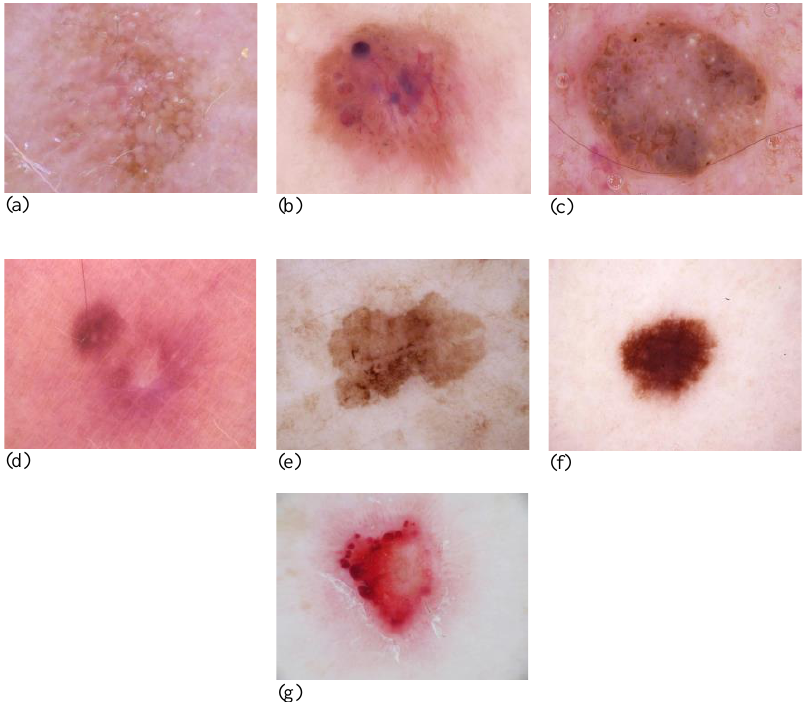
Figure 2. Sample skin cancer images from the dataset. ( a ) AKIEC; ( b ) BCC; ( c ) BKL; ( d ) DF; ( e ) MEL; ( f ) NV; and ( g ) VASC.